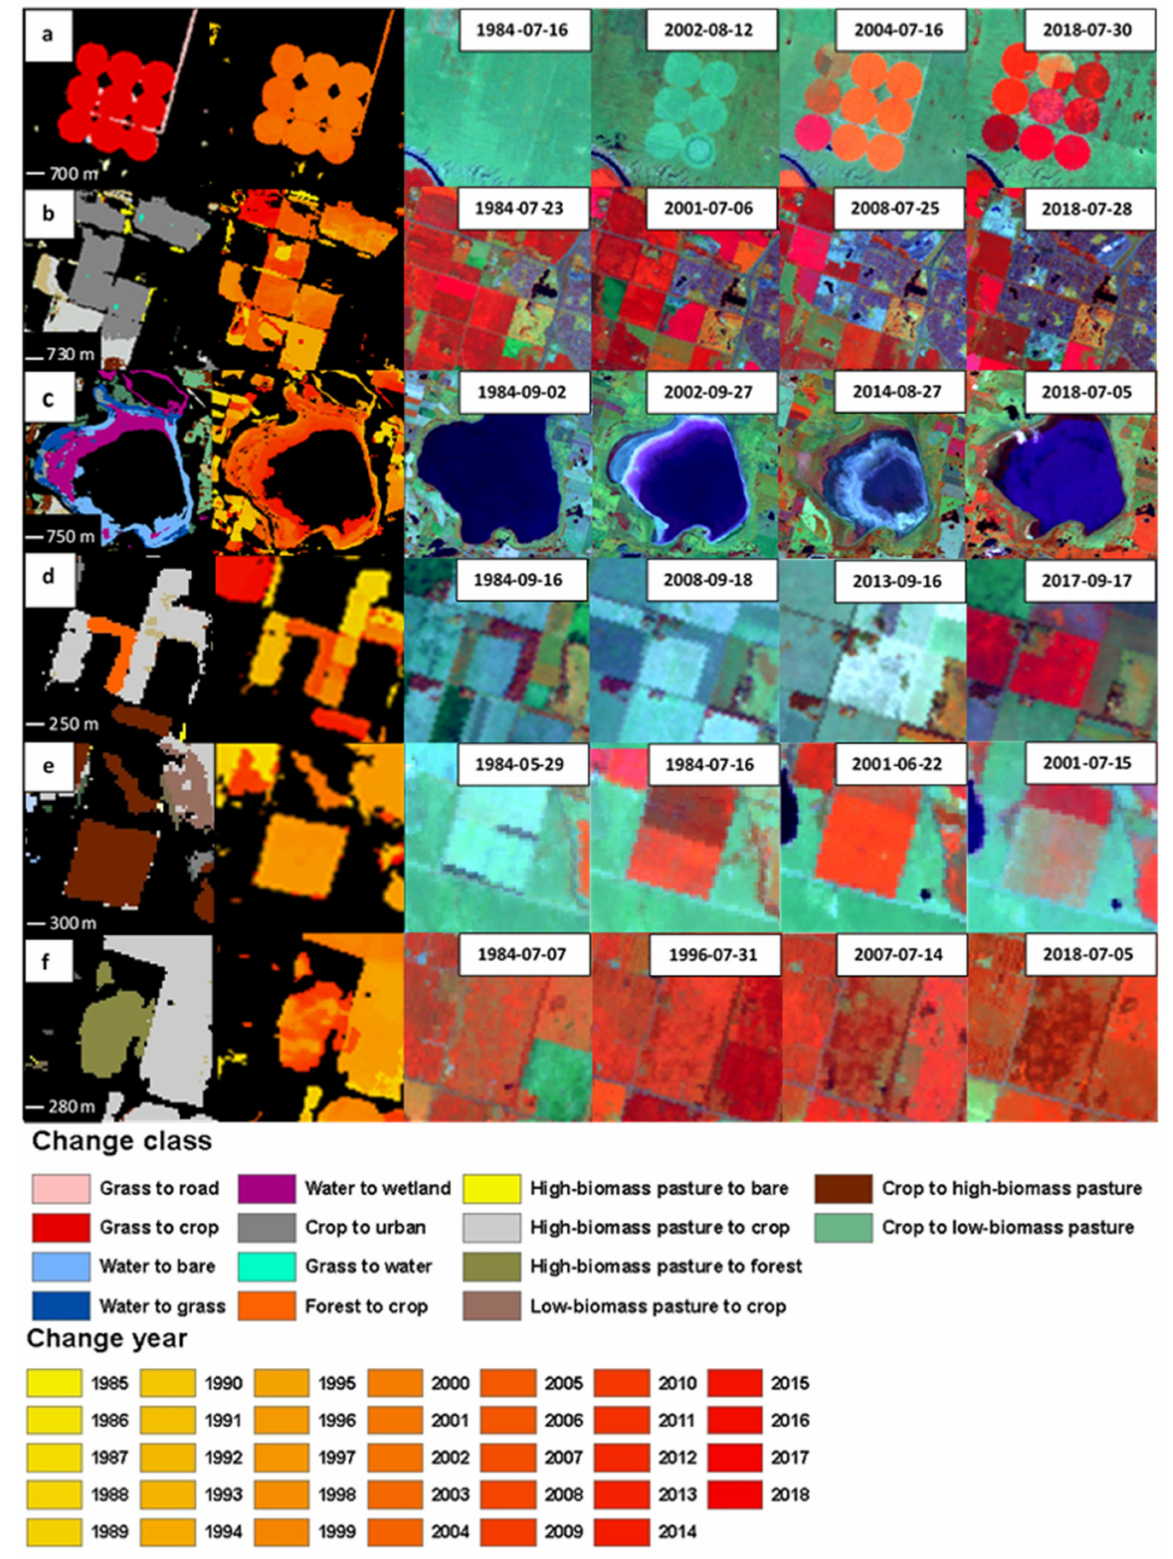
Figure 6. Example change detection results; ( a ) grass to crop and road, ( b ) crop to urban, ( c ) water-body shrinkage, ( d ) forest to crop, ( e ) crop to pasture, and ( f ) pasture to forest. The order from left to right is the result for the change class and year followed by example Landsat images displayed as the near-infrared, short-wave infrared, and red band